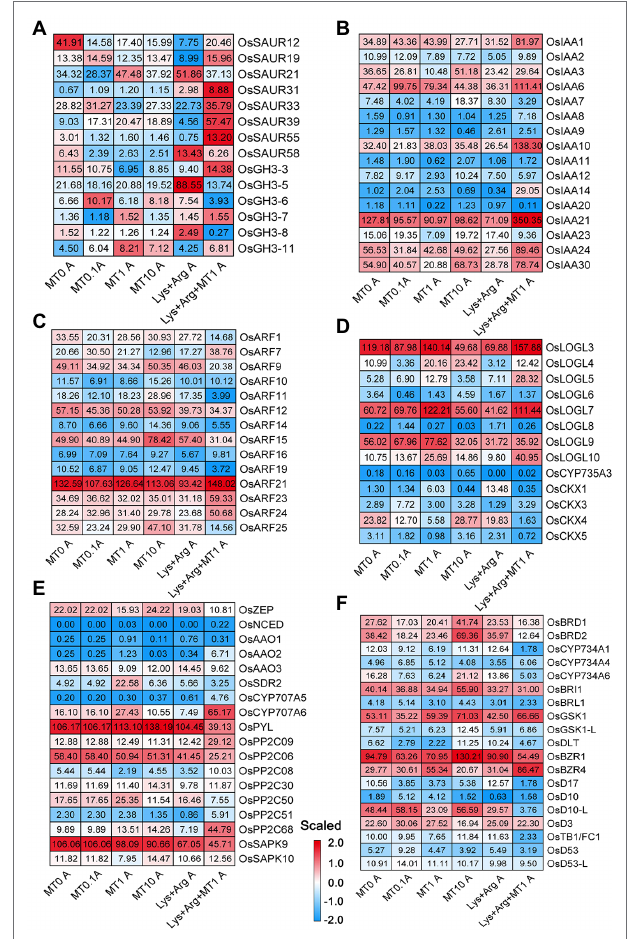
FIGURE 5 | The expression of genes involved in plant hormone signal transduction in axillary bud under different concentrations of melatonin and amino acids. Heatmaps display the expression patterns of genes involved in auxin (A–C) , cytokinin (D) , abscisic acid (E) , ethylene and strigolactone (F) . Red and blue represent the highest and lowest level of expression. MT represents melatonin, Lys represents lysine, and Arg represents arginine. A at the bottom of each graph represents axillary bud, and B at the bottom of each graph represents basal part. MT0, MT0.1, MT1 and MT10 represents melatonin at 0 μ m, 0.1 μ m, 1 μ m and 10 μ m,